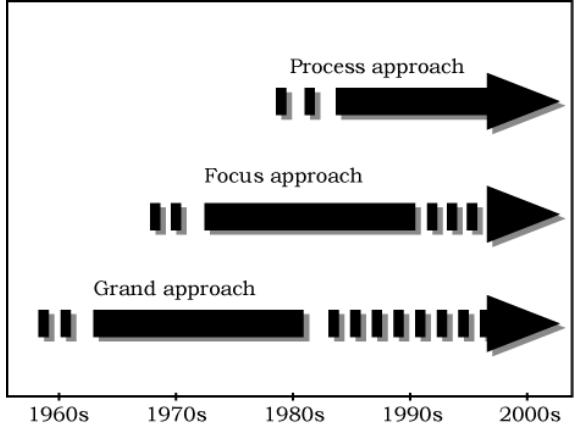
Figure 1. Product development research